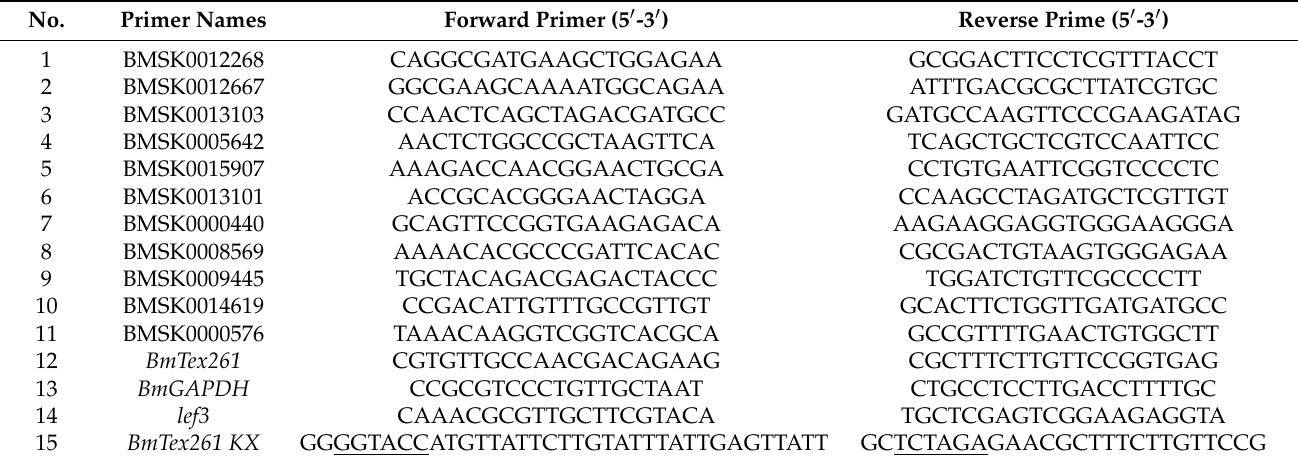
Table 1. List of primers used in this